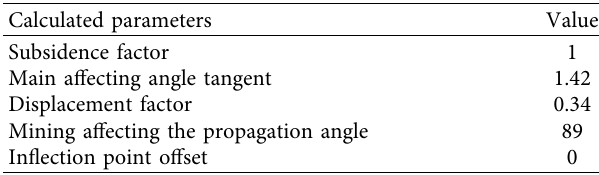
Table 2: Parameters of surface movement.